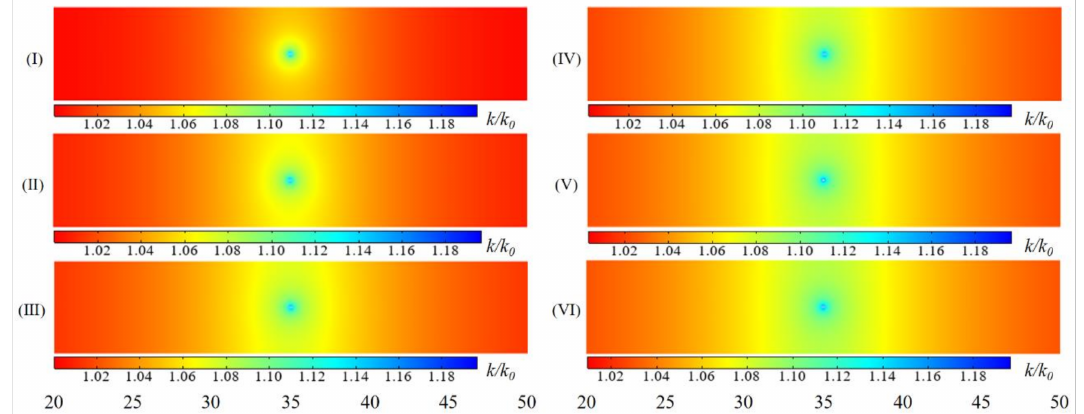
Figure 11. Cloud chart of coal permeability distribution around borehole at different drainage times: